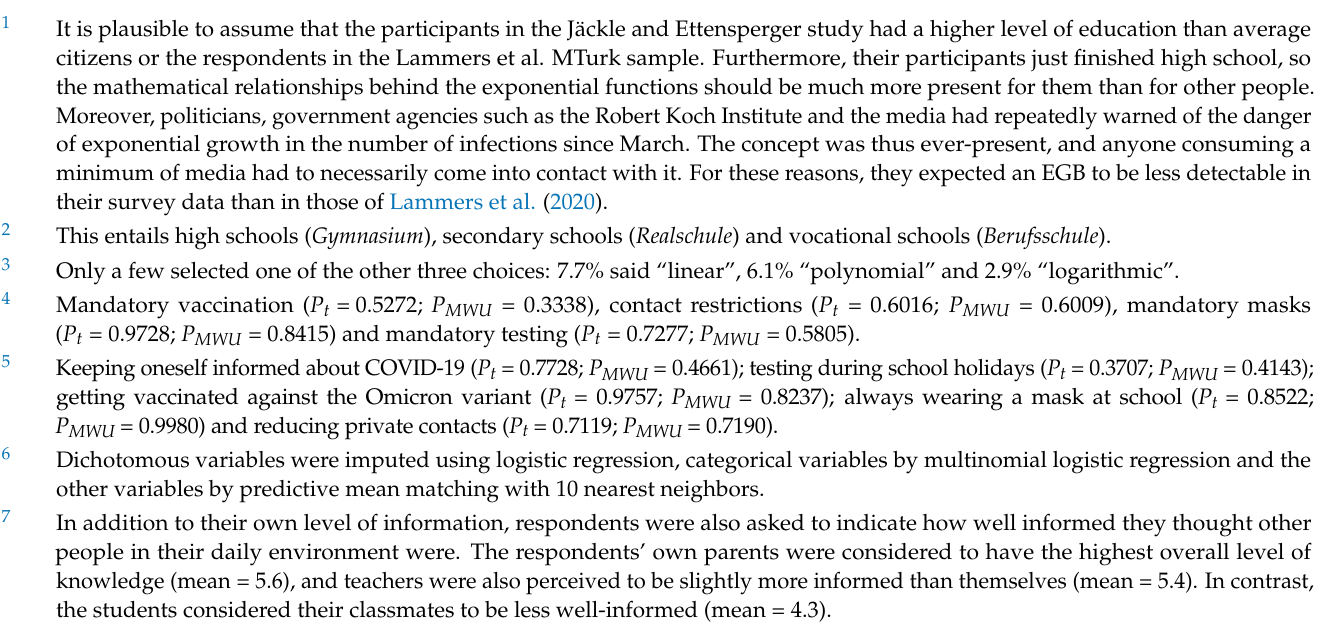
Analysis; Table S3: Regressions Explaining Approval Ratings of General anti-COVID-19 Measures; Table S4: Regressions Explaining Willingness to Perform Specific anti-COVID-19 Measures; Figure S1: Description of the Overall Sample by Age, Gender and Vaccination Status; Figure S2: Results of the COVID-19 Quiz; Figure S3: COVID-19 Infections, Symptoms and Fear of Infection; Figure S4: Effect of Fear of COVID-19 Infection among those not Infected; Figure S5: Effect of Symptoms of COVID-19 Infection Among those